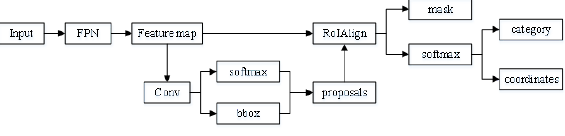
Fig. 1. Mask RCNN